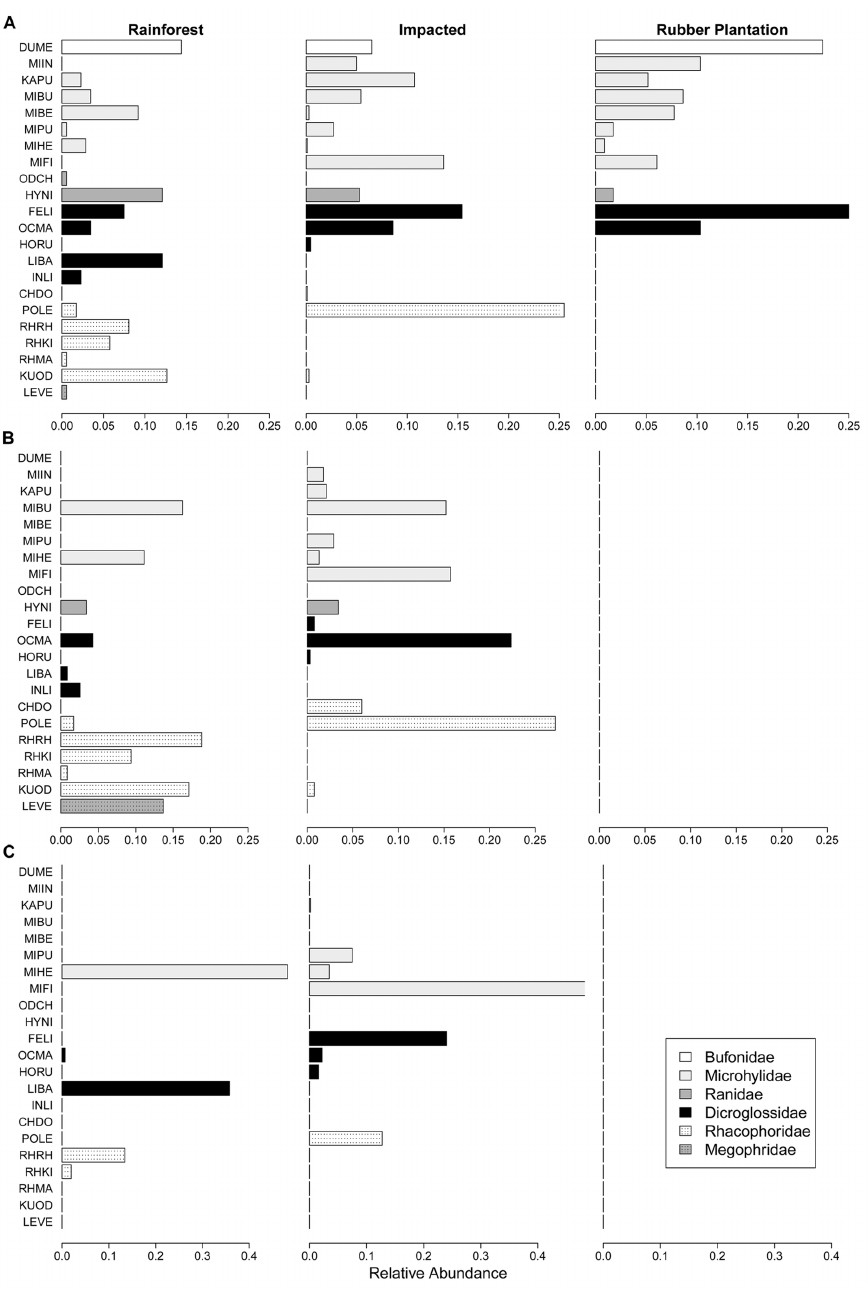
Figure 1. Frog communities at rainforest, impacted and rubber plantation sites from non-breeding and breeding surveys. Relative abundances of the 22 frog species recorded in A) non-breeding surveys, B) calling surveys and C) oviposition surveys in rainforest, impacted and rubber plantation sites. Relative abundances were calculated within each habitat type based on number of individuals encountered (A), male calling abundance (B), and tadpole density (C). Color of bars corresponds to family species belongs to. Species name codes in the order they appear in the figure are: DUME: Duttaphrynus melanostictus , MIIN: Micryletta inornata , KAPU: Kaloula pulchra , MIBU: Microhyla butleri , MIBE: Microhyla berdmorei , MIPU: Microhyla pulchra , MIHE: Microhyla heymonsii , MIFI: Microhyla fissipies , FELI: Fejervarya limnocharis , HORU: Hoplobatrachus rugulosus , LIBA: Limnonectes bannaensis , INLI: Ingerana liui , OCMA: Occidozyga martensii , ODCH: Odorrana chloronota , HYNI: Hylarana nigrovittata , CHDO: Chiromantis doriae , POLE: Polypedates leucomystax, RHRH: Rhacophorus rhodopus , RHKI: Rhacophorus kio , RHMA: Rhacophorus maximus , KUOD: Kurixalus odontotarsus , LEVE: Leptolalax ventripunctatus . See http://www.iucnredlist.org for naming authorities. doi: 10.1371/journal.pone.0073688.g001 PLOS ONE |